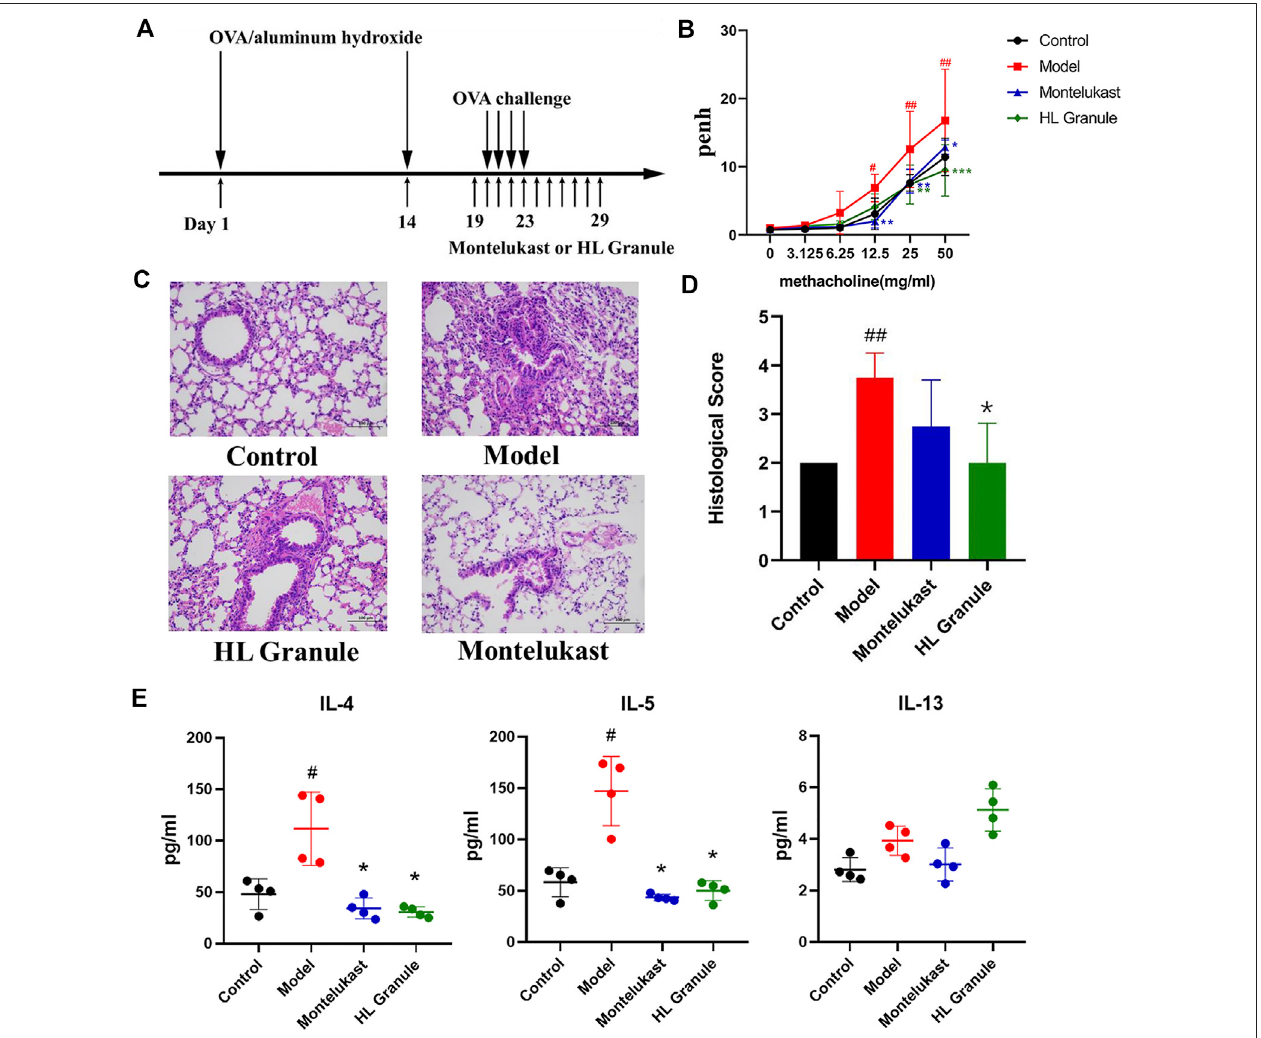
FIGURE 1 | The protective effect of HL Granule on acute asthma in mice. (A) The fl owchart of induced and treatment in the model of acute asthma. The model of acute asthma was established and sensitized by intraperitoneal injection of 0.2 ml OVA, followed by atomization of 3% OVA. (B) Pehn in each group. The data was collected in response to gradient concentration (0, 3.125, 6.25, 12.5, 25, and 50 mg/ml) of inhaled MCh. (C, D) Representative HE staining pictures (x200, C) and histological scores, n (cid:2) 4. (E) The expressions of IL-4, IL-5 and IL-13 in BALF by Elisa. Results are presented as mean ± SD, statistics in (B) was using two-way ANOVA, n (cid:2) 3; statistics in D and E were using Kruskal-Wallis test, n (cid:2) 4; # p < 0.05, ## p < 0.01 compared to control group; * p < 0.05, compared to model group.